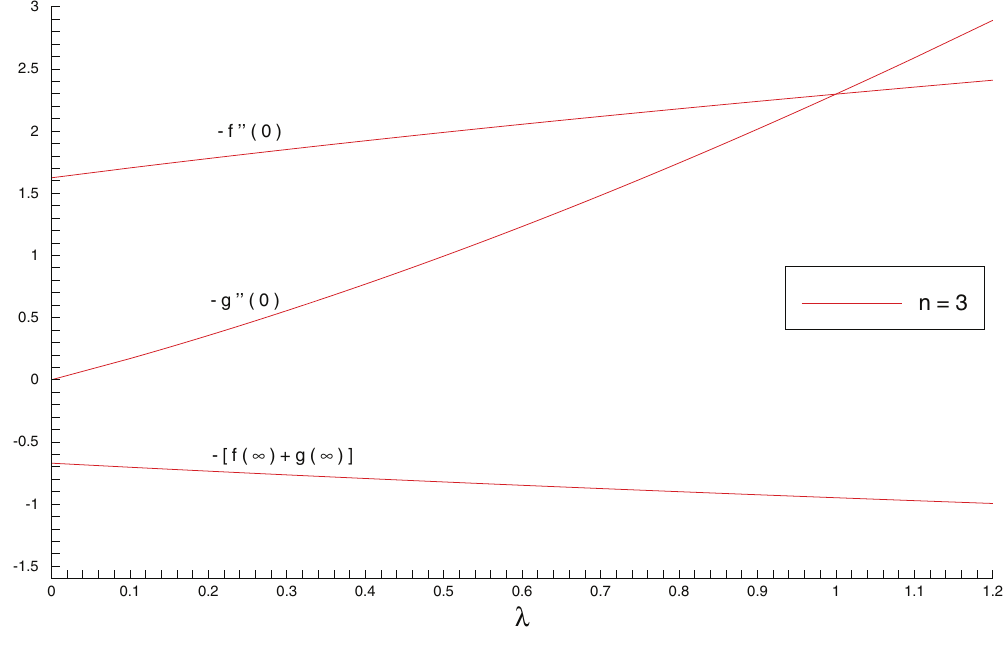
Figure 5. Influence of stretching rates ratio l on the skin friction coefficients f 00 (0) and g 00 (0) and entrainment velocity f ( ? ) z g ( ? ) :